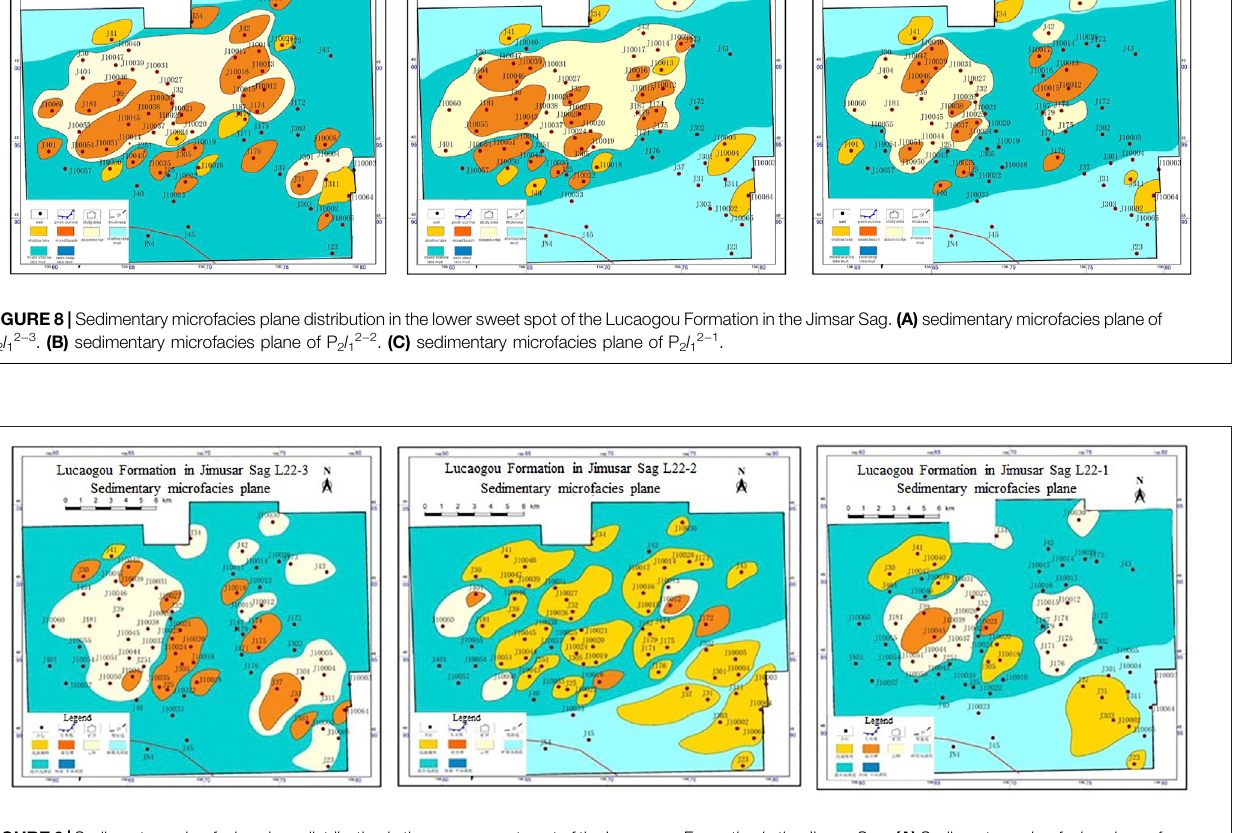
Frontiers in Earth Science |